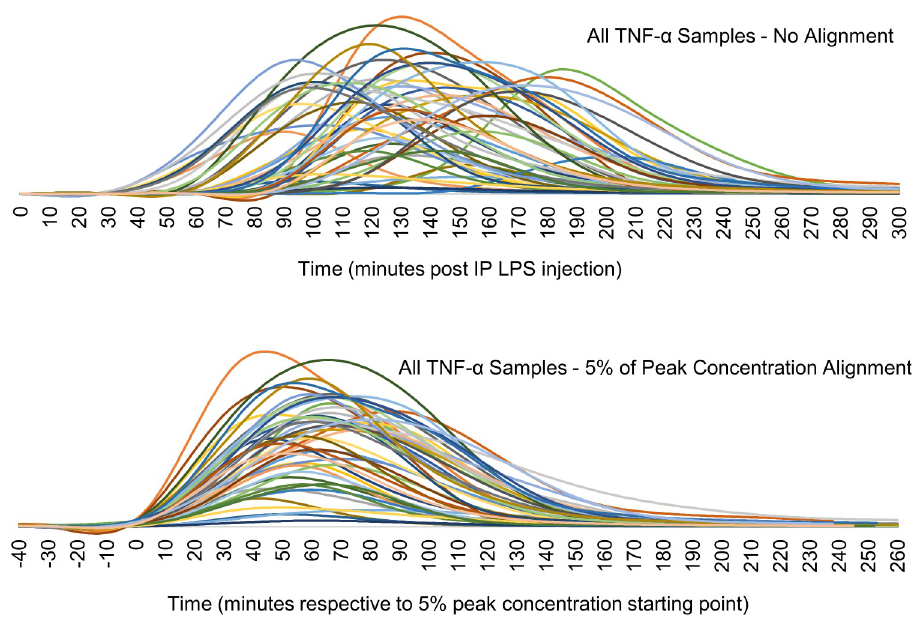
Fig 2. Comparison of individual TNF- α temporal profiles from all rats analyzed with LPS administered IP. Top shows unaligned plots with highly variable starting points. Bottom shows the result of aligning utilizing our technique of 5% peak concentration as a starting point (t =